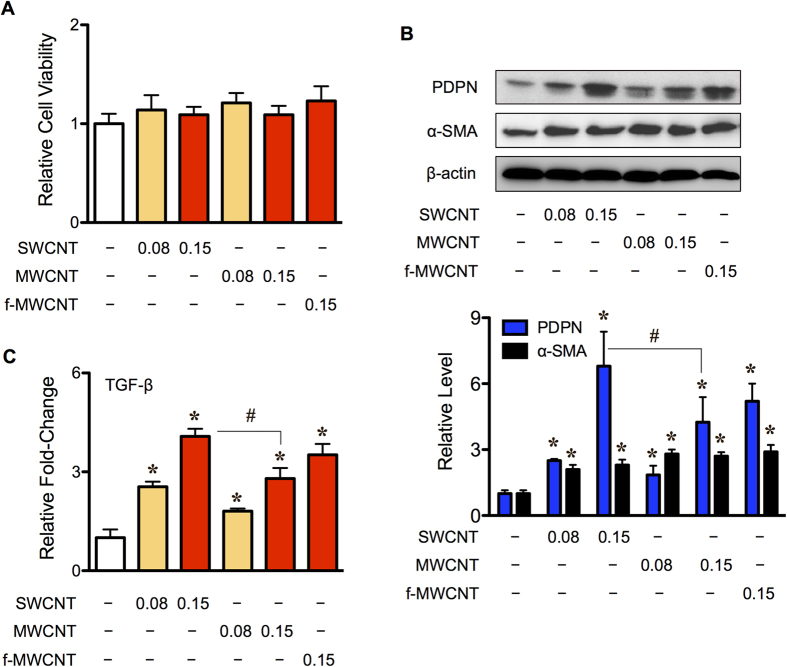
Carbon nanotubes induce transformation of primary human lung fibroblasts into cancer-associated fibroblasts.Subconfluent monolayers of human lung fibroblasts were treated with various concentrations (0–0.15 μg/cm2) of SWCNT, MWCNT, or f-MWCNT for 48 h. (A) Analysis of cell viability and proliferation using the WST-1 assay. (B) Western blot analysis of the cancer-associated fibroblast marker podoplanin (PDPN) and myofibroblast marker α-SMA. β-actin was used to confirm equal loading of the samples. Immunoblot signals were quantified by densitometry, and mean data from three independent experiments (one of which is shown here) were normalized to the results obtained in cells without CNT treatment (control). (C) Secreted TGF-β levels in the culture medium of CNT-treated lung fibroblasts as determined by ELISA. Data are mean ± SD (n = 3). *P < 0.05 vs. vehicle-treated control cells. #P < 0.05 vs SWCNT-treated cells.